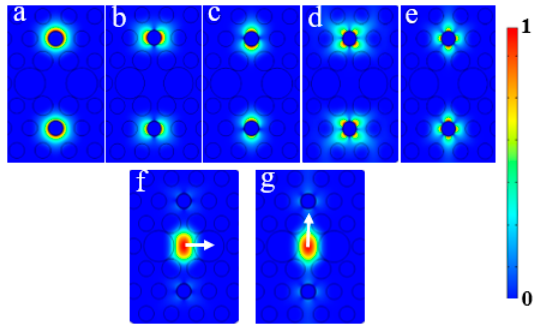
Figure 2. The electric field distributions: ( a ) 0-SPP mode; ( b ) 1-SPP1mode; ( c ) 1-SPP2mode; ( d ) 2-SPP1 mode; ( e ) 2-SPP2 mode; ( f ) x-pol fundamental mode (x-FM); ( g ) y-pol fundamental mode (y- FM).